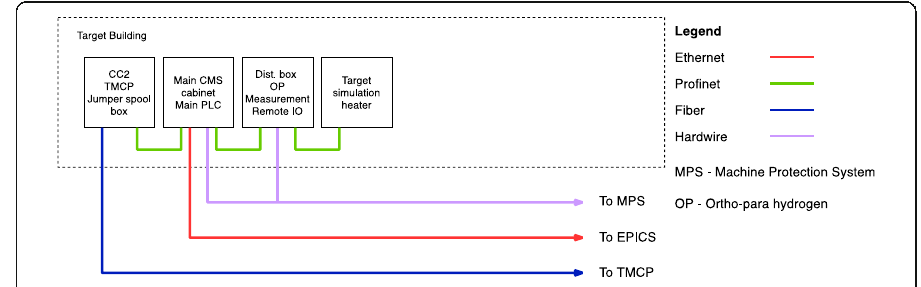
Fig. 13 Simplified control systems architecture CMS and related